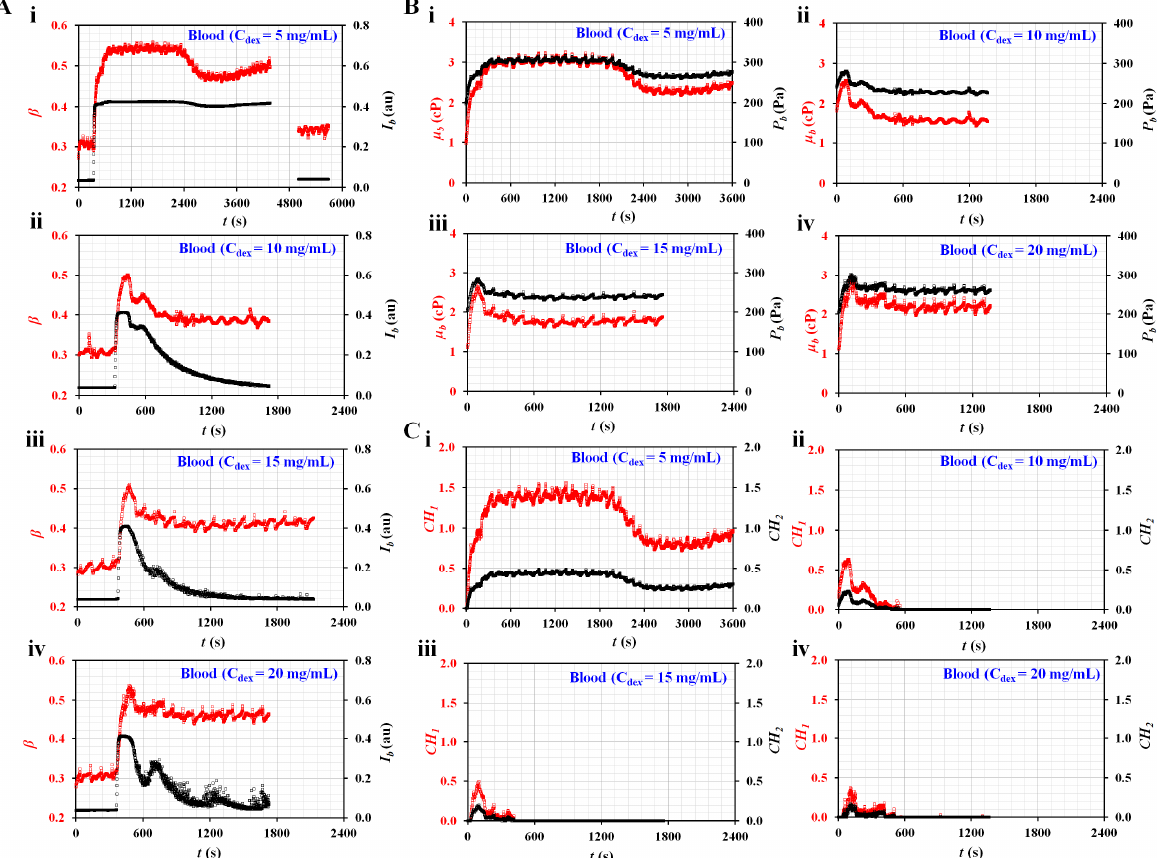
Figure 5. Quantitative evaluations of RBC sedimentation for RBC aggregation-enhanced bloods. The degree in RBC sedimentation was controlled by preparing dextran solution with various concentra- tions. The hematocrit was set at Hct = 50%. The flow rates of both fluids were set at 0.5 mL/h. ( A ) Temporal variations in I b and β with respect to the concentration of the dextran solution (C dex ) (( A -i) C dex = 5 mg/mL, (A-ii) C dex = 10 mg/mL, (A-iii) C dex = 15 mg/mL, and (A-iv) C dex = 20 mg/mL). ( B ) Temporal variations in µ b and P b with respect to C dex ((B-i) C dex = 5 mg/mL, (B-ii) C dex = 10